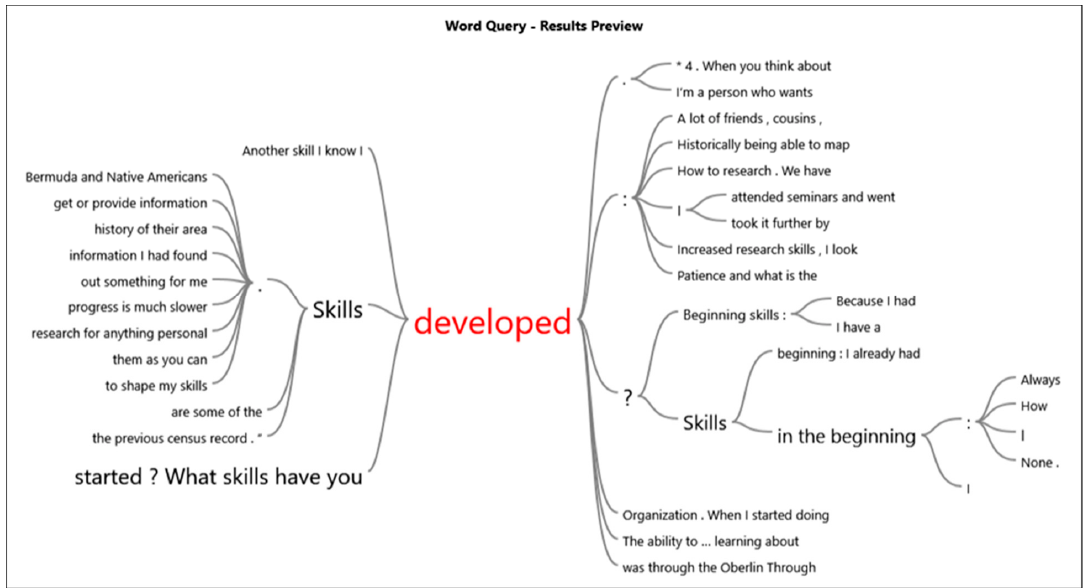
Figure A1. Example: Word tree using the keyword “education.”